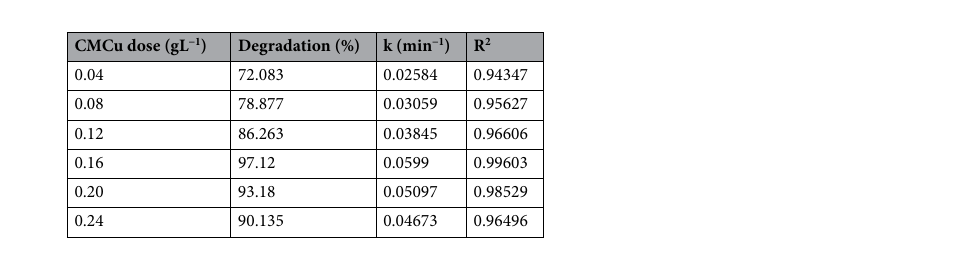
Table 2. Evaluation of various parameters for catalyst dose optimization for MG dye